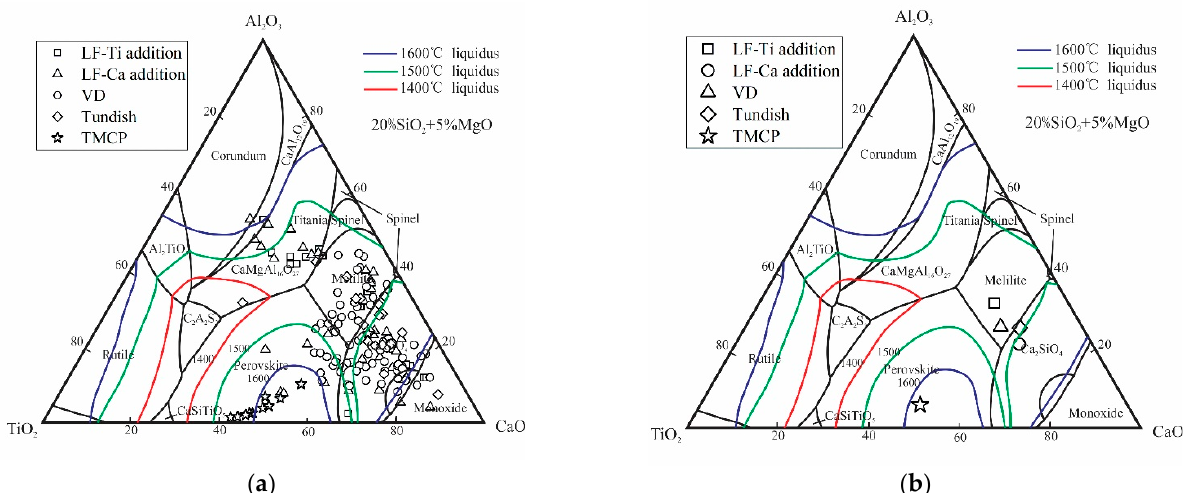
Figure 6. Pseudo-ternary phase diagrams CaO-Al 2 O 3 -TiO 2 at fixed 20%SiO 2 (14.8–23.2% SiO 2 ) and 5%MgO (2.7–7.8%MgO); ( a ) experimental data; ( b ) average data.